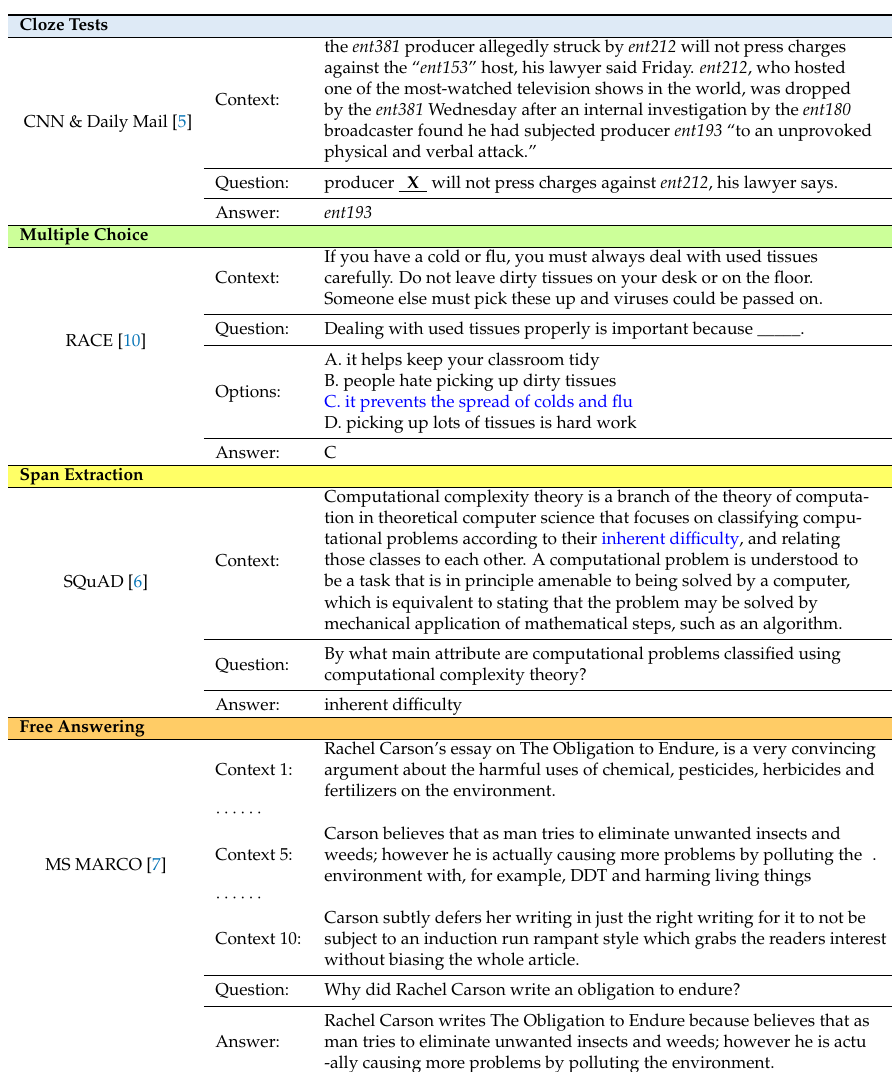
Table 2. A few examples of MRC